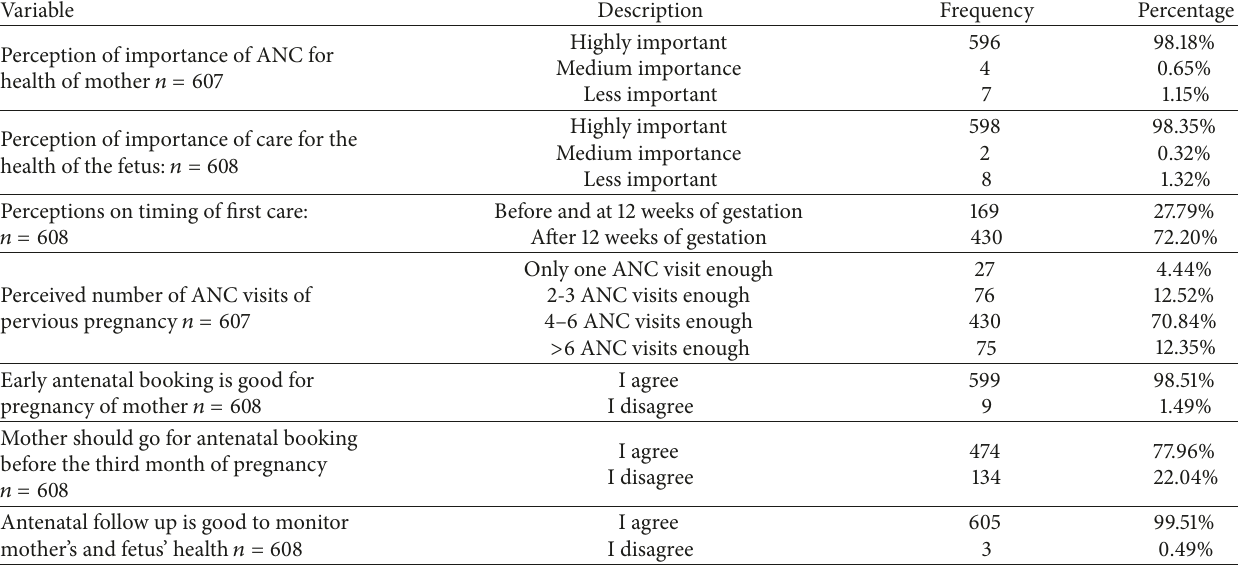
Table 3: Knowledge and perception of ANC service utilization and timing of first ANC, Shebedino in district SNNPR, Ethiopia, in 2015.